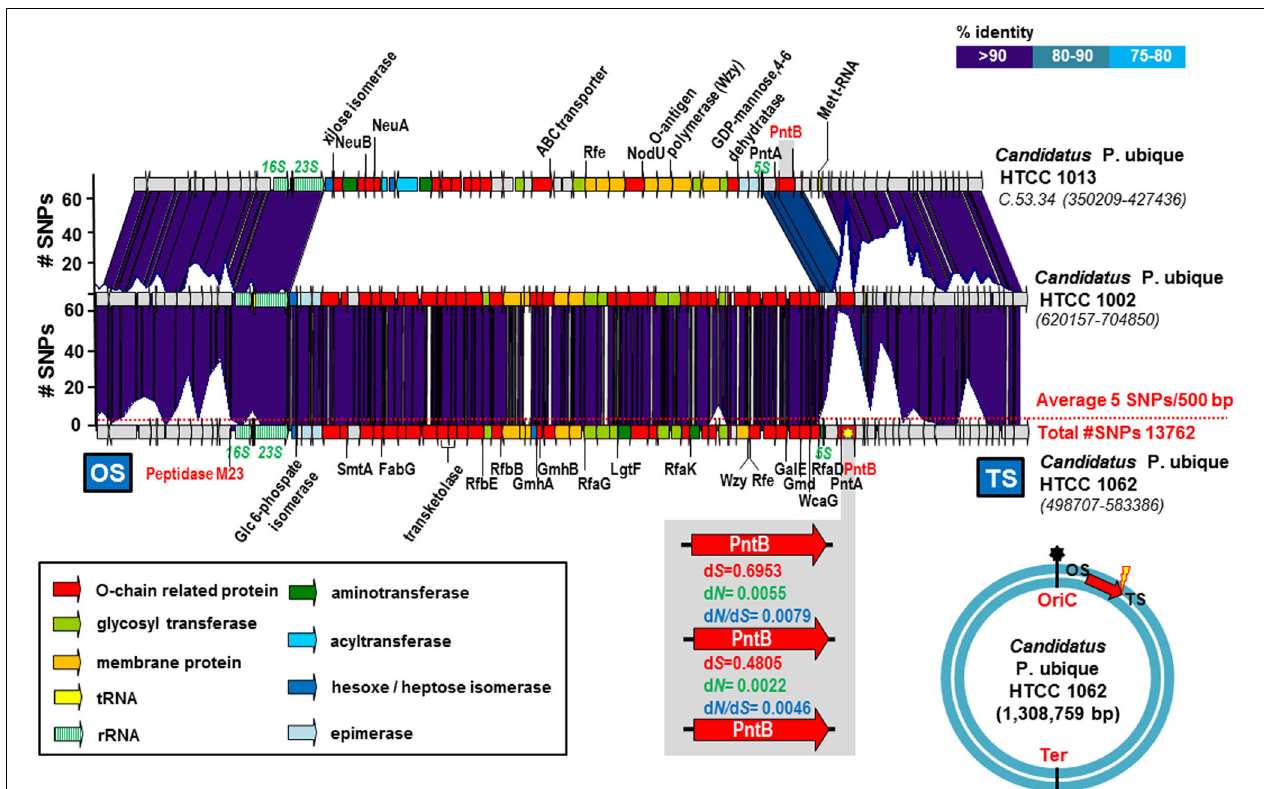
FIGURE 1 | Candidatus Pelagibacter ubique HTCC 1013, 1002, and 1062 O-chain cluster. The plot above the genomes indicates the number of SNPs in a 500bp window. The average number of SNPs in the genome is indicated by a red dot line. The region enlarged in the gray box indicates the rate of non-synonymous (d N ), synonymous (d S ) substitutions and the d N /d S ratios for the gene which accumulates the largest number of SNPs that encodes a PntB: beta subunit of the NAD (P) transhydrogenase (marked with a yellow